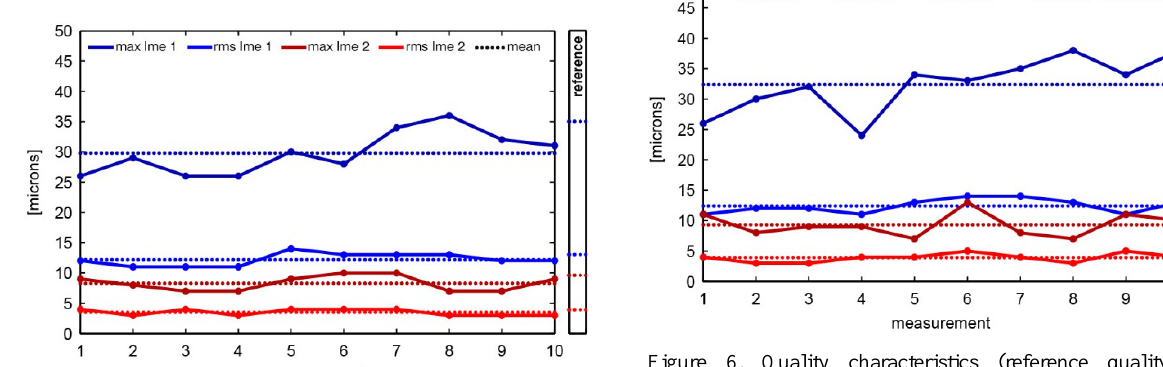
Figure 6. Quality characteristics (reference quality with different target detector settings and synchronisation)